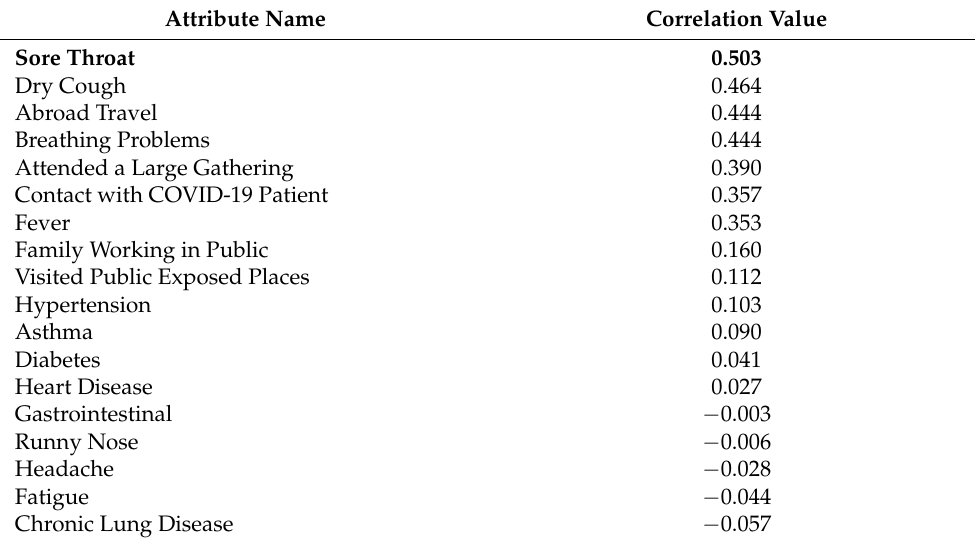
Table 3. The correlation of predictors to COVID-19